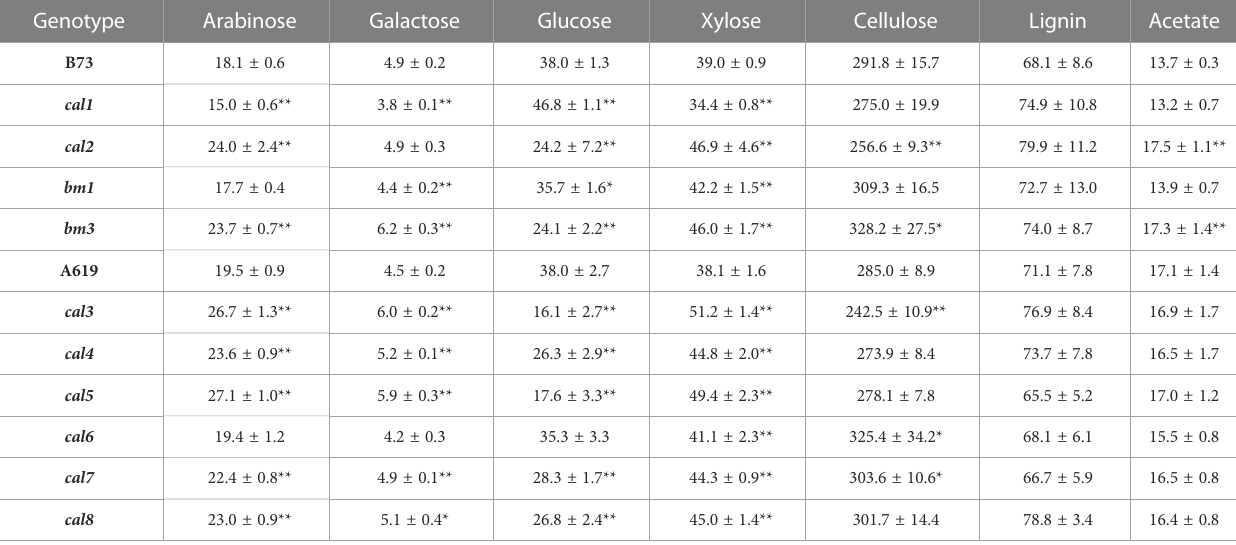
Monosaccharidecompositionvaluesareshownasthemeanandaverageoftherelativecontentofeachmonosaccharide(in%)of5biologicalreplicates.100%correspondstothesumofAra,Gal, Glc and Xyl. cal1, cal2, bm1, and bm3 are in B73 genetic background. cal3, cal4, cal5, cal6, cal7, and cal8 are in A619 genetic background. Asterisk(s) indicate levels of statistical signi fi cance between each mutant and corresponding wild-type plant determined by two-tailed unpaired Student t-test at p-value < 0.01 (**), p-value < 0.05 (*).